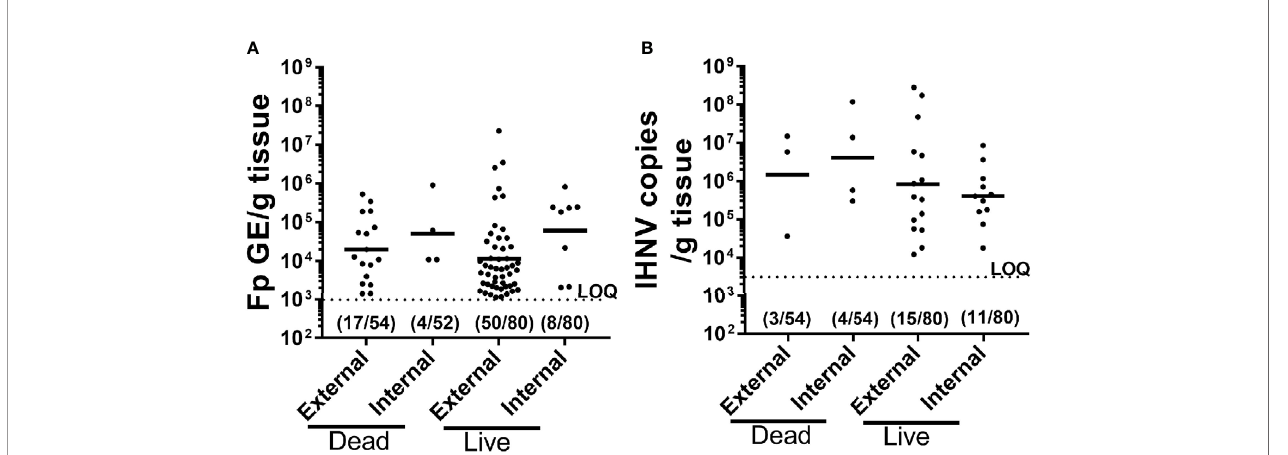
FIGURE 3 | Comparison of pathogen prevalence and load from live and dead-sampled fi sh held in constant reuse water. Plots compare F . psychrophilum (A) and IHNV (B) prevalence and load (A) ; Log10(bacterial DNA copies/g tissue); (B) Log10 [viral RNA copies/g tissue or DNA copies)] for mortalities (died between days 8- 19) and live-sampled fi sh (days 10 and 12) reared under constant reuse water (Donor and Constant groups combined). External pathogen was measured in gill/ fi n- clip homogenates while internal pathogen load was measured in kidney/spleen homogenates. Individual fi sh loads are indicated in addition to geometric mean. Limit of quanti fi cation for both qPCR assays is indicated by dotted line. Numbers indicate positive fi sh and total sampled for each group. The full datasets for live-sampled and dead-sampled fi sh are in Supplemental Tables 1 and 2 ,